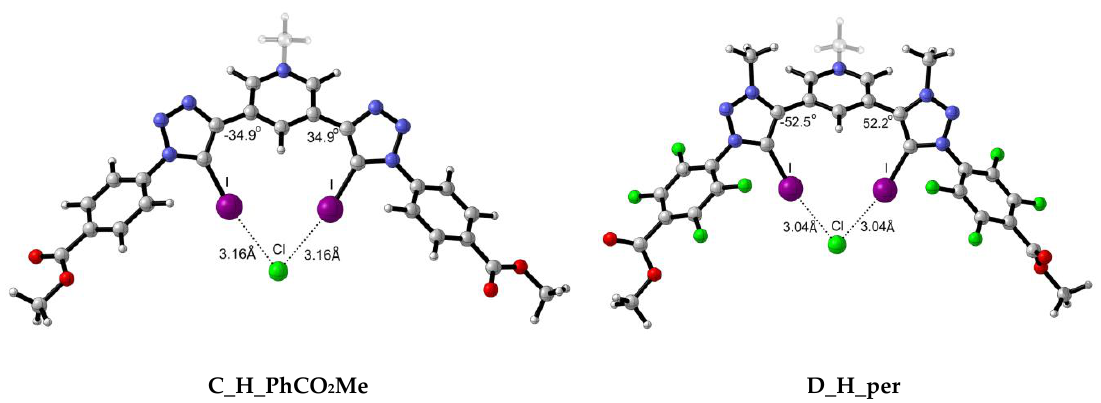
Figure 6. Representative optimised structures for the interaction between scaffolds C and D with Cl − anion.